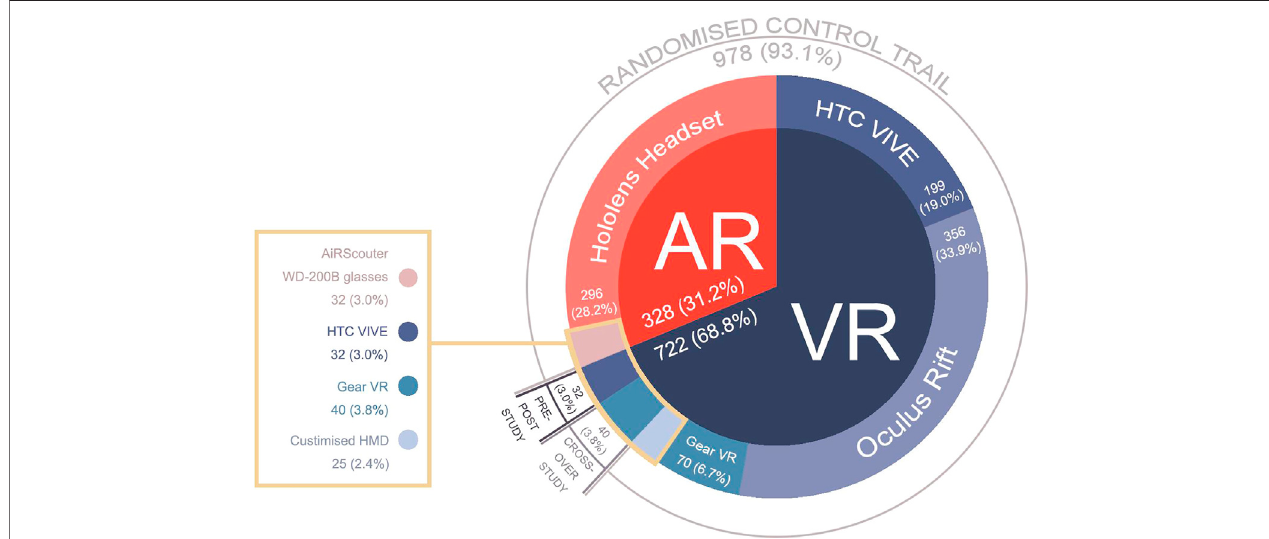
FIGURE 3 | Participation distribution of included studies.